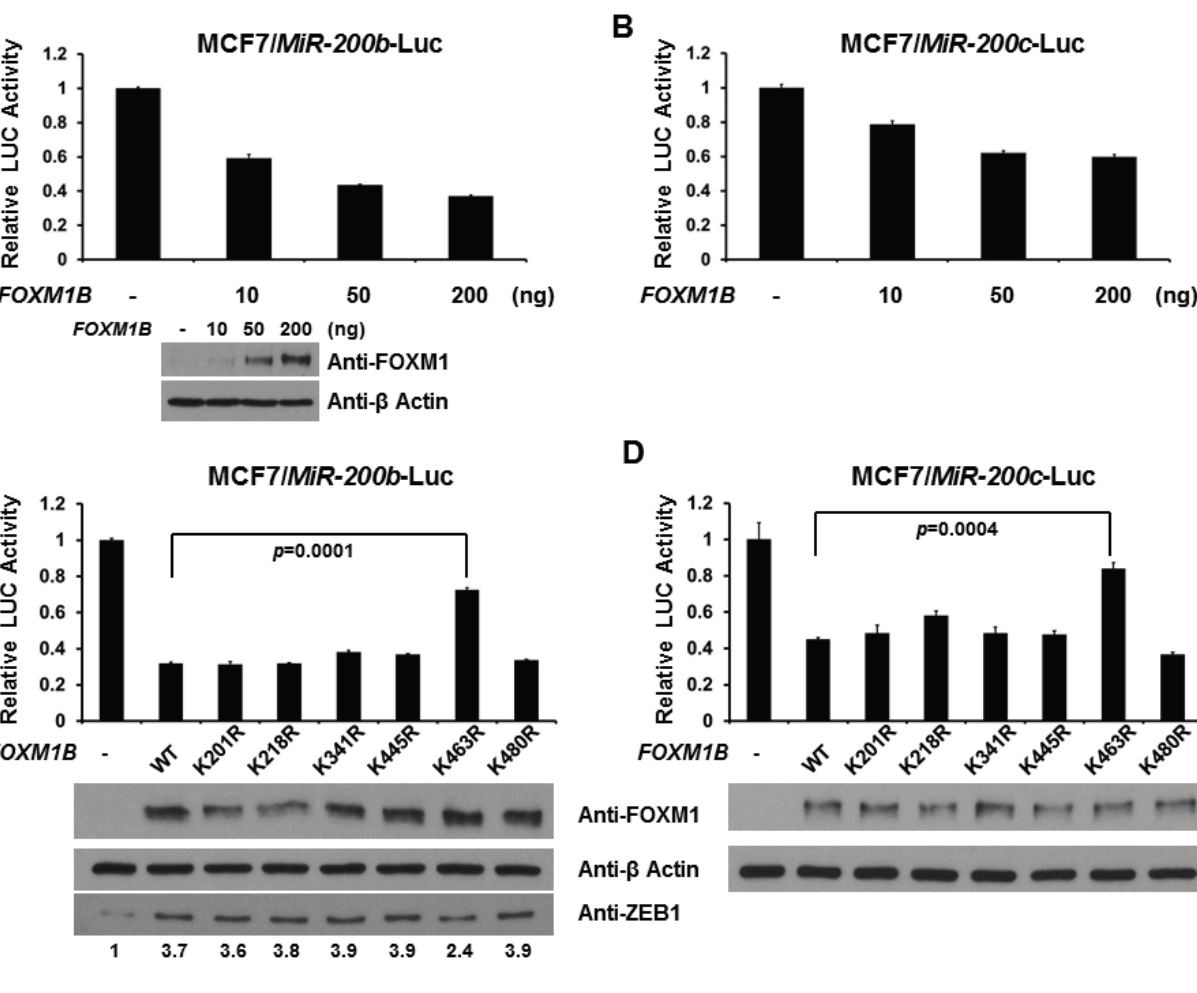
Figure 4. Loss of SUMOylation relieves the repression of MiR-200b/c promoter by FOXM1B. MCF7 cells were co-transfected with different amounts (10, 50, and 200 ng) of FOXM1B expression plasmid and a reporter plasmid with MiR200b promoter ( A ) or MiR200c promoter ( B ); MCF7 cells were transfected, where indicated, with WT or mutant FOXM1B expression plasmid and a reporter plasmid with MiR200b promoter ( C ) or MiR200c promoter ( D ). Luciferase activities were measured 48 h after transfection and normalized with Renilla activity. Relative LUC activity (fold activation) was calculated and plotted. The expression levels of FOXM1B in MCF7 cells from the reporter assays were validated using anti-FOXM1 immunoblotting. The expression levels of ZEB1 in MCF7 cells from the reporter assays with MiR200b promoter were validated using anti-ZEB1 immunoblotting. Experiments were performed three times with similar